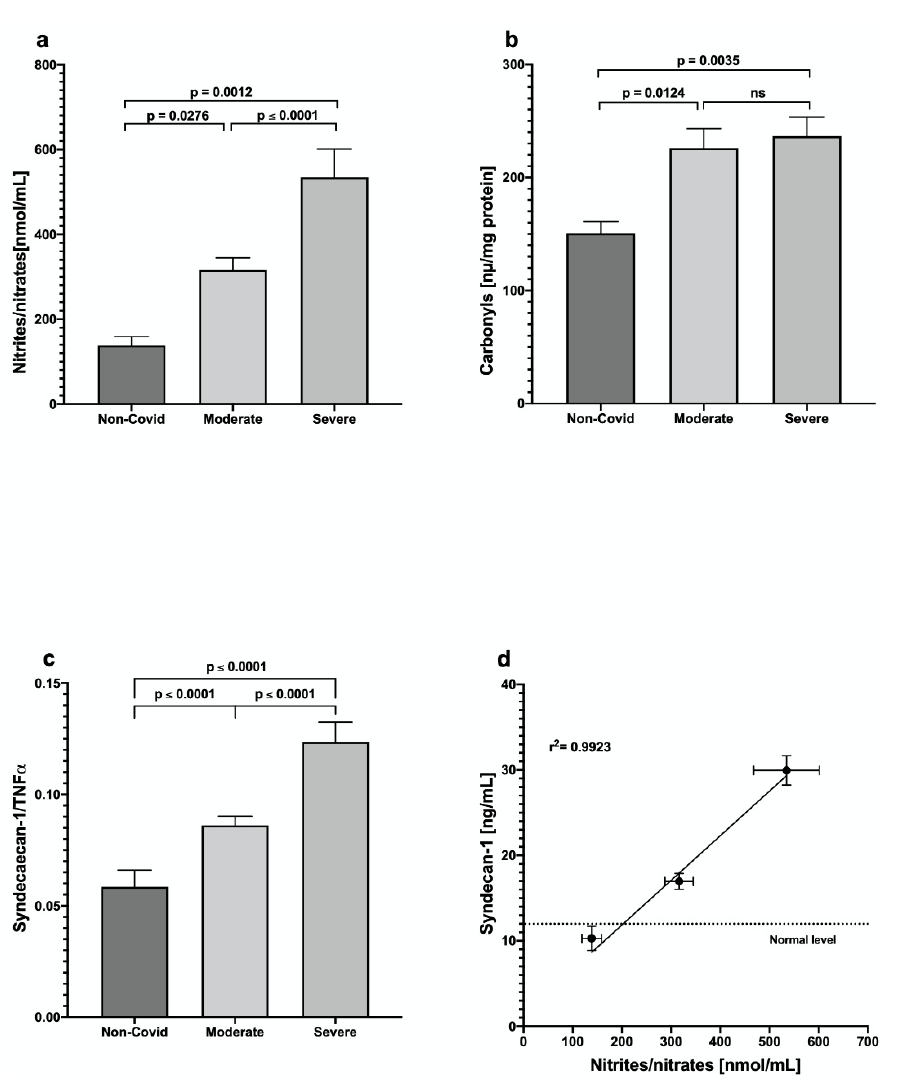
Figure 3. Evaluation of the oxidative status of patients with COVID-19 disease: ( a ) Nitrites/nitrates, ( b ) Carbonyls, ( c ) Syndecan-1/TNF- α and ( d ) Syndecan-1. Values are expressed as means ± SE.